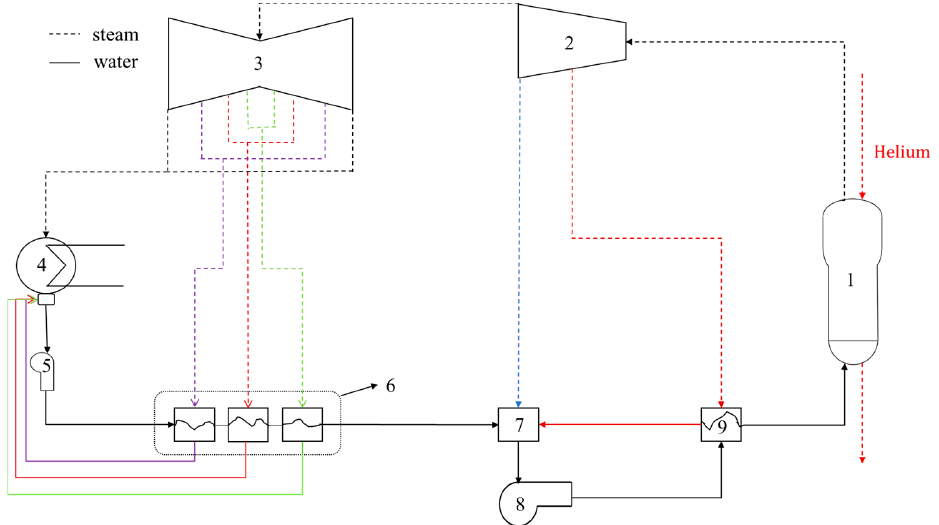
Figure 1. Physical model of the HTR secondary circuit.